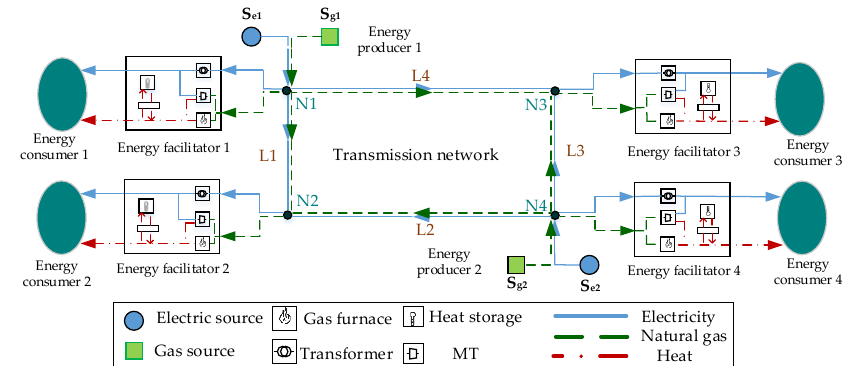
Figure 6. A sample case of MECS.